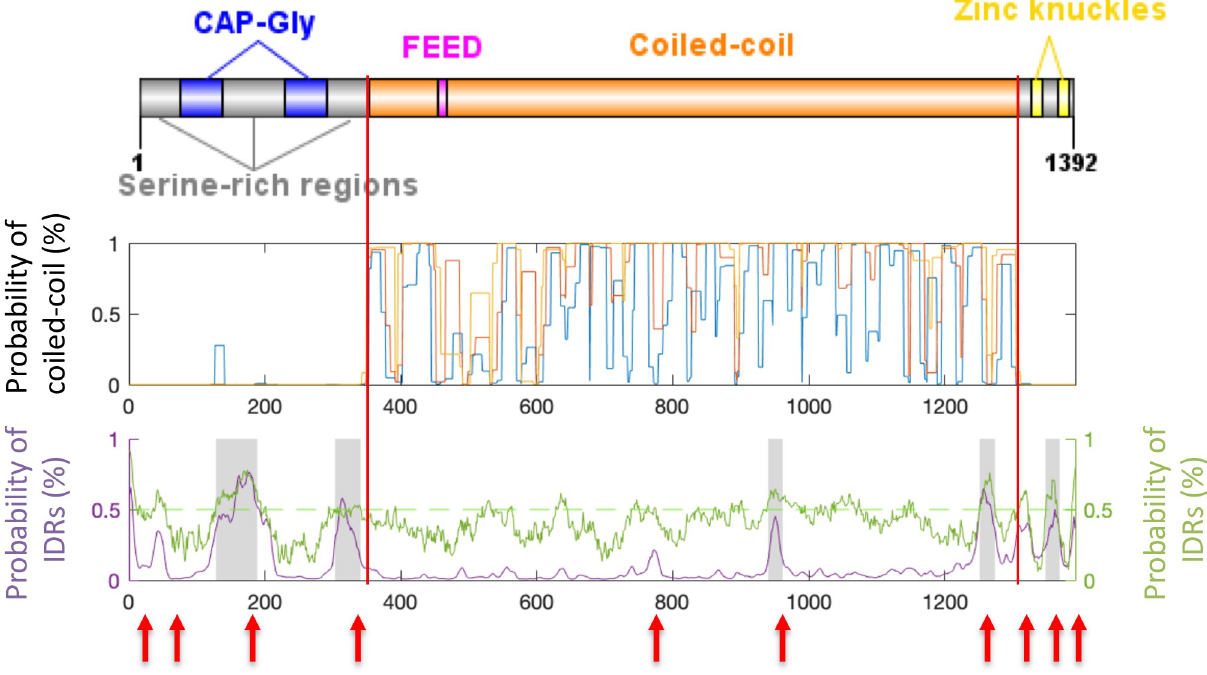
Fig 7. Analysis of coiled-coil domains and IDRs for human CLIP-170 (AAA35693.1). (Top) CLIP-170 domain structure summary. The N-terminal domain includes the 2 CAP-Gly domains and 3 serine-rich regions. The coiled-coil domain is labeled in orange, and its boundaries are indicated with two red lines. The C-terminal domain contains two zinc-knuckle motifs (yellow). (Middle) Analysis of coiled-coil propensity as predicted by COILS. The colored lines represent the probability that a region assumes a coiled-coil conformation, as assessed for different windows (7AA, blue; 14 AA, orange; 21 AA yellow), with 1 on the Y-axis indicating 100% likelihood. (Bottom) IDR predictions (Y-axis) as function of amino acid position (X-axis), with 1 indicating 100% likelihood. The purple line represents the probability of IDRs as predicted by Espritz, with red arrows indicating the 10 regions predicted to be disordered. The grey areas indicate the IDRs as predicted by MobiDB-lite. The green line represents the probability of IDRs as predicted by IUPred2A, and the light green indicates the probability of 0.5.